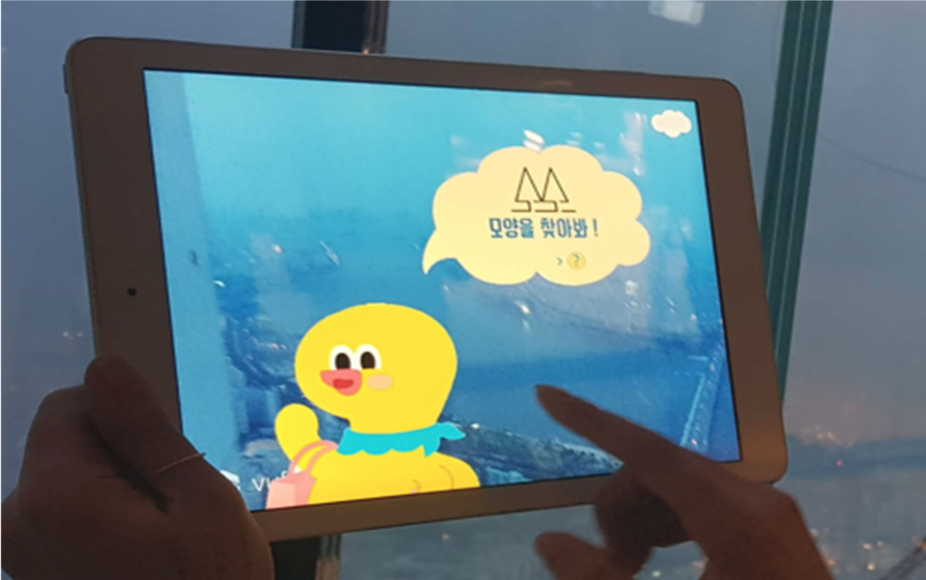
Figure 5. Users need to find the landmark icon in the observatory space that matches one of the tourist attraction categories they have selected.